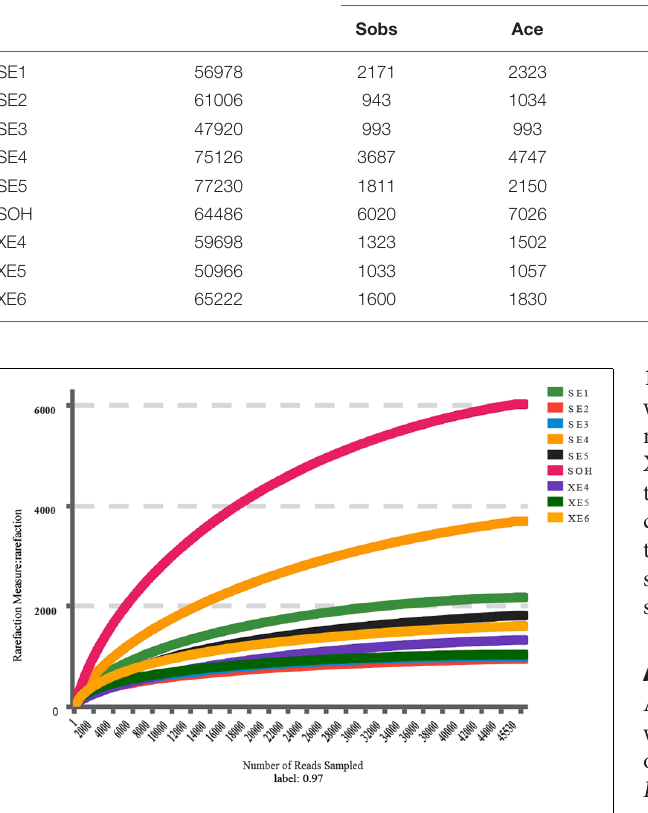
FIGURE 1 | Rarefaction analysis of the V3/V4 MiSeq sequencing reads of the 16S rRNA gene from the nine corrosion samples at a 97% sequence similarity cutoff value.